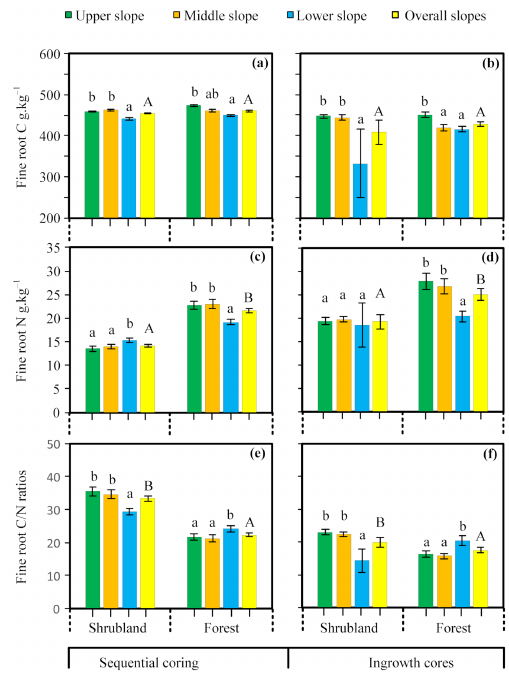
Figure 3. C root and N root of living fine roots in different slope positions and vegetations of a karst ecosystem. Lowercase letters indicate significant differences in living fine roots ( p < 0.05) among the three slopes; capital letters indicate significant differences in living fine roots ( p < 0.05) between shrubland and forest. ( a , c , e ) were the patterns of fine root C concentrations, N concentrations, and C/N ratios used by sequential coring, respectively; ( b , d , f ) were the patterns of fine root C concentra- tions, N concentrations, and C/N ratios used by ingrowth cores, respectively. Table 4. Fine root nutrients responded to slope position and vegetation in a karst ecosystem.